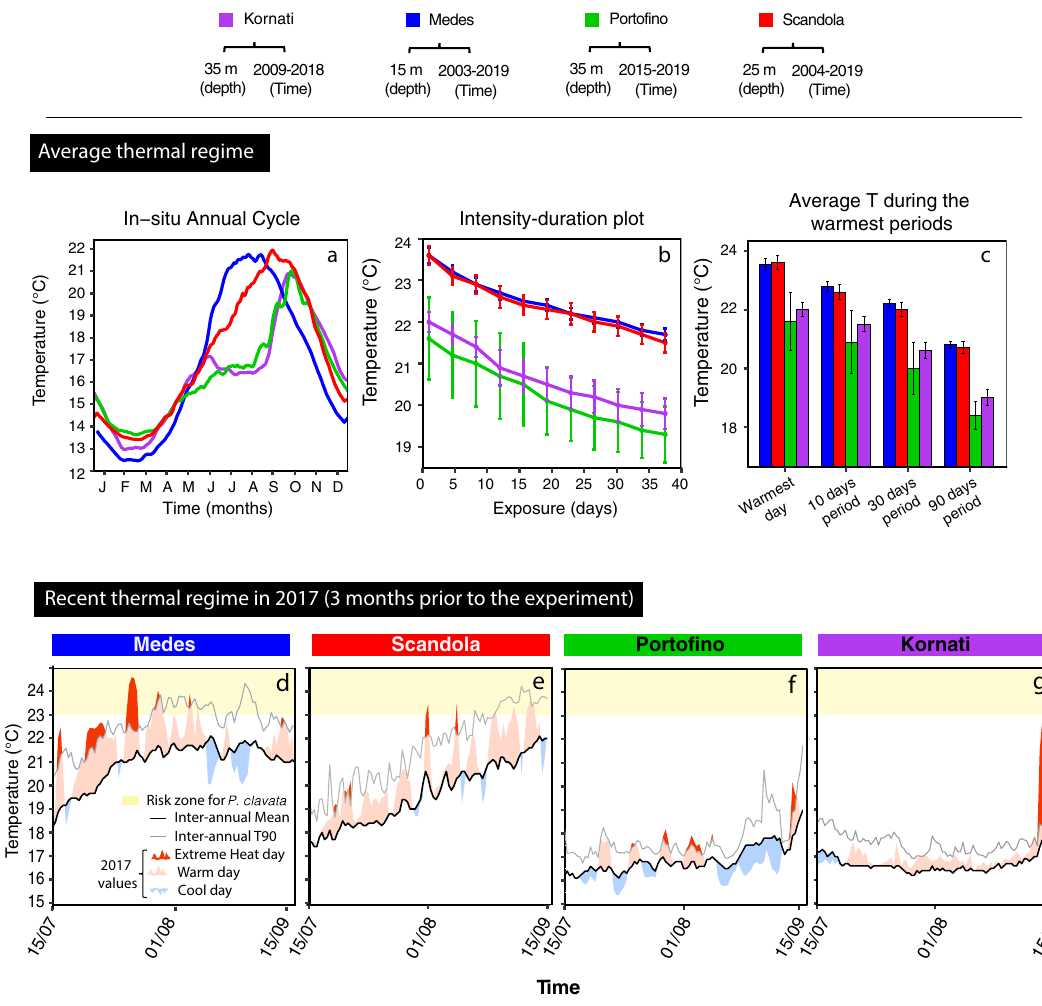
Figure 2. ( a ) Inter-annual average of daily mean temperatures during the annual cycle at each locality at the depths on which the populations were sampled. ( b ) Intensity-duration plot indicating the mean number of days (± SE) at warm temperatures during the 10% warmest period of the year at each locality. ( c ) Mean locality temperature (± SE) during the warmest day, 10-days, 30-days and 90-days of each year. ( d – g ) Daily temperature values observed in-situ at each locality during the three months prior to the experiment (from 15th June until 15th September, 2017) with respect to the inter-annual mean (iMean) and the inter-annual percentile 90th (iT90). Days over the iT90 threshold were considered as “extreme heat days”. Days over the iMean but below the iT90 were considered as “warm days”. Days below the iMean were considered as cool days. Finally, the risk zone for P. clavata (days over 23 °C) is represented in